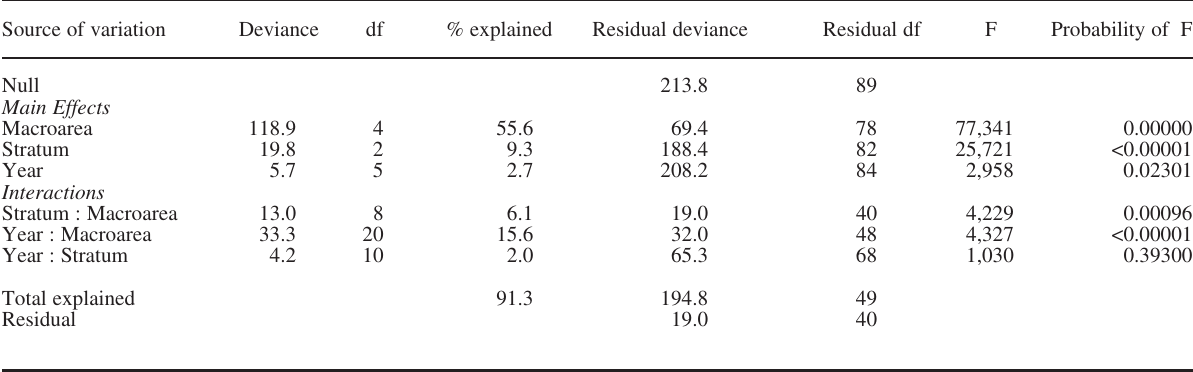
T ABLE 3. – Citharus linguatula : analysis of deviance table for generalised linear models fitted to “MEDITS” biomass indices (g/km 2 ) obtained in the years 1994-1999. Source of